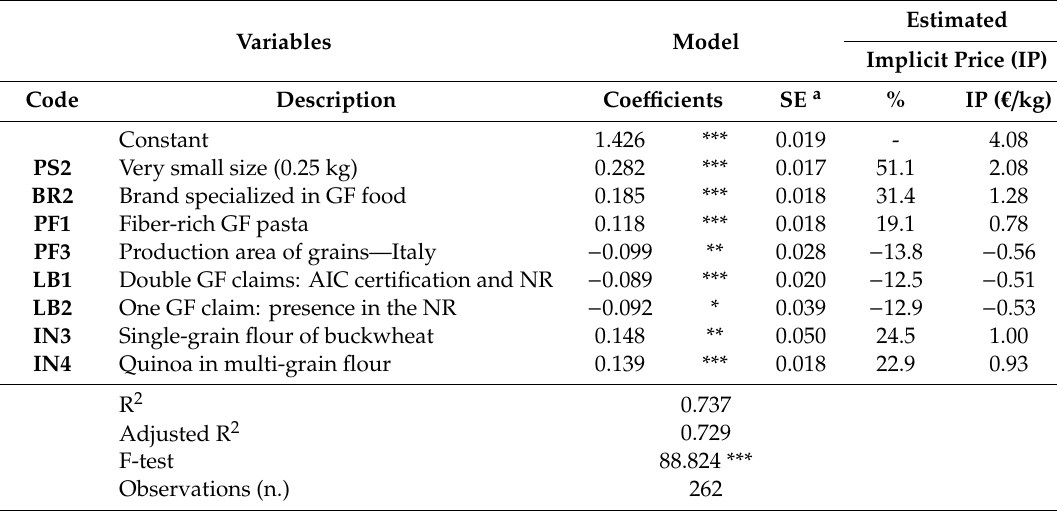
Table 4. Estimated hedonic price